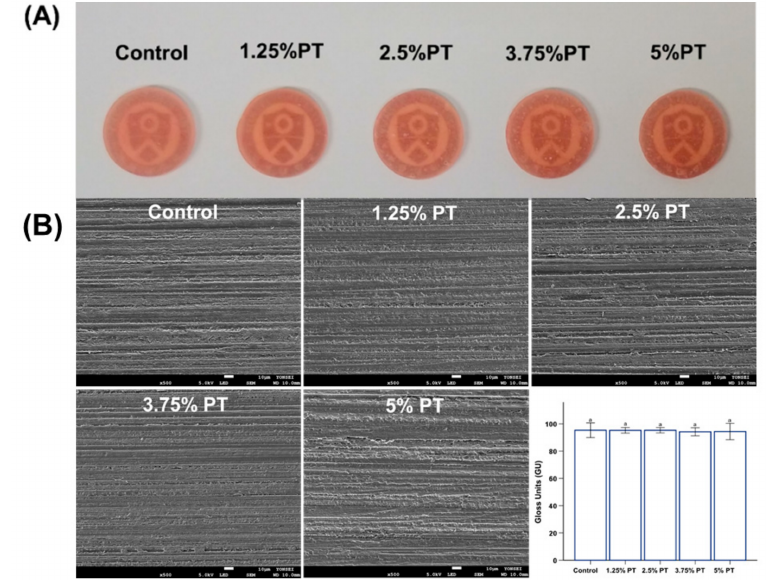
Figure 3. Representative images of PMMA samples; control, 1.25% PT, 2.5% PT, 3.75% PT and 5% PT ( A ), comparison of gloss values between di ff erent groups of PMMA samples ( B ). Same lowercase alphabetical letters above the bar graph indicate there are no significant di ff erences between the groups (e.g., there are no di ff erences between group with ‘a’ and another group with ‘a’ above the bar) ( p > 0.05). Di ff erences in lowercase alphabetical letters above the bar graph indicate significant di ff erences between the groups (e.g., there are di ff erences between the group with ‘a’ and the group with ‘b’.) ( p <